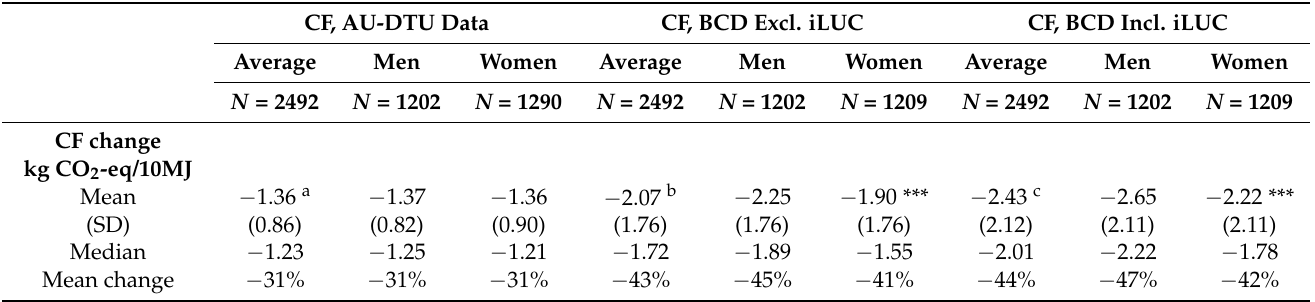
Table 2. The carbon footprint (CF) change from current to plant-rich diet at the retail gate (kg CO 2 -eq per 10 MJ) calculated using three different CF data